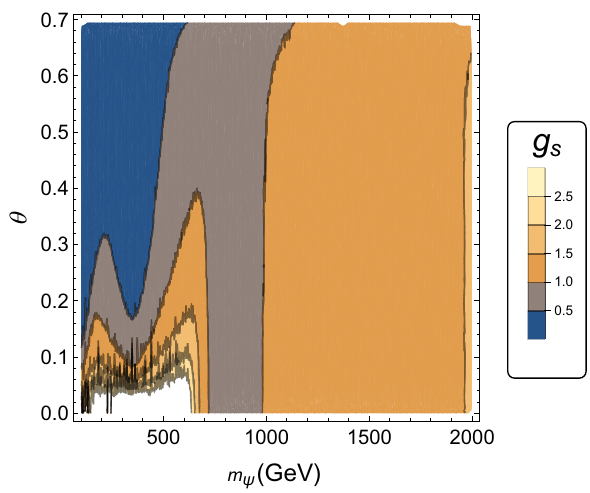
Fig. 3 The contour plot of the θ in terms of dark matter mass m ψ ; the color illustrates the change in coupling g s